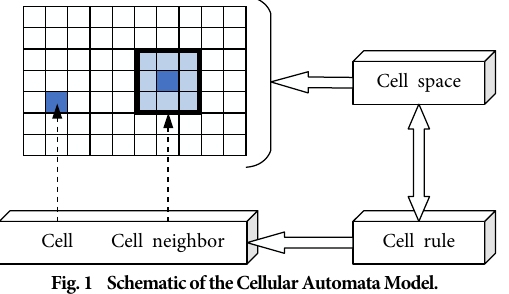
Fig. 1 Schematic of the Cellular Automata